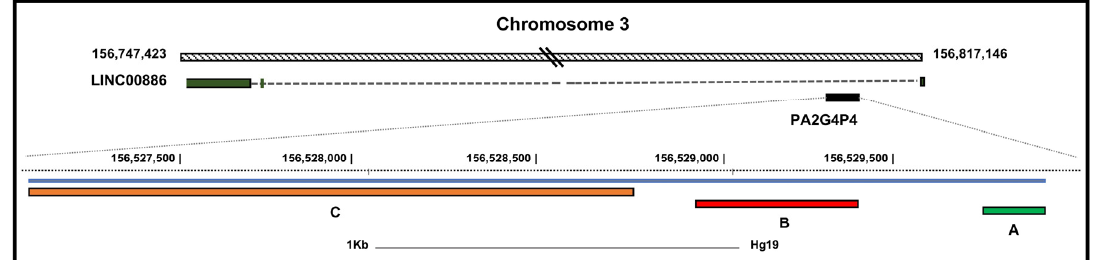
Figure 1. PA2G4P4 genomic location and structure. In the upper part of the figure, the relative genomic position and organization of PA2G4P4 and LINC00886 are schematically represented. In the lower part, the PA2G4P4 region is expanded. The gray line schematically represents the annotated PA2G4P4 transcript. Segment A corresponds to the 5 (cid:48) RACE product, extending the PA2G4P4 region with 104 nucleotides; segment B corresponds to the in situ hybridization probe sequence; segment C spans the PA2G4 homolog region (modified from UCSC BLAT). PA2G4P4, proliferation-associated